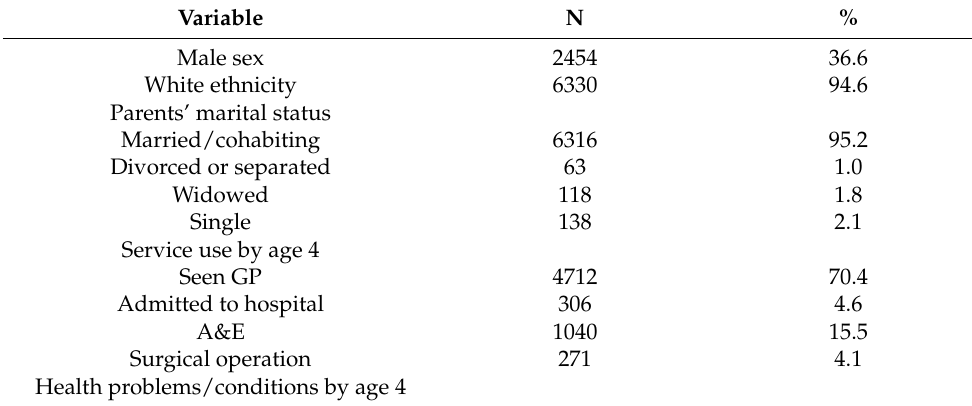
Table 1. Sample characteristics (categorical